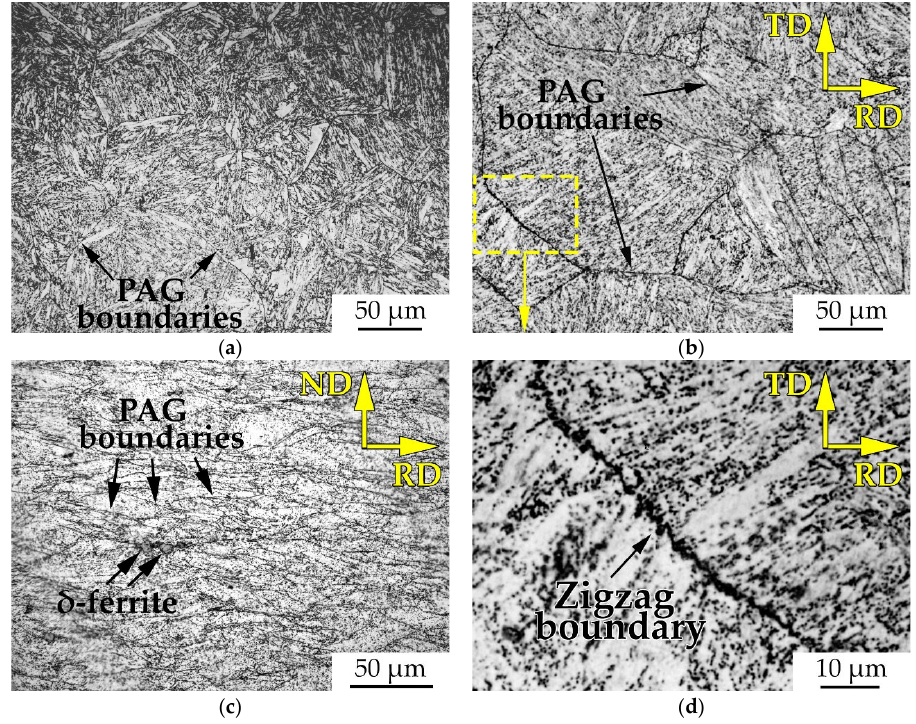
Figure 2. Optical micrograph of the steel EK ‐ 181 microstructure after THT ( a ) and HTMT ( b – d ): b , d —section parallel to the rolling plane, c —cross section.